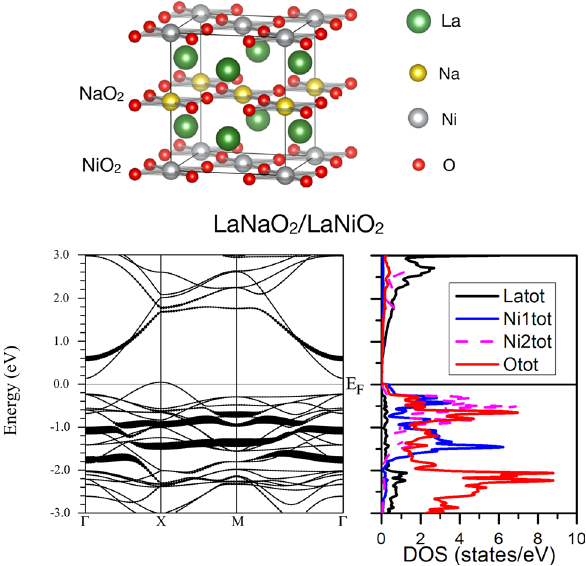
Figure 5. Top panel. Supercell constructed alternating one layer of LaNiO 2 and one layer of LaNaO 2 . The Ni-Ni direct off-plane hopping is blocked structurally by a single layer of LaNaO 2 . However, the La- d off-plane hopping is not blocked. Na atoms in yellow, La atoms in green, O atoms in red, Ni atoms in gray. Bottom left panel. Band structure of a multilayer (LaNaO 2 ) 1 /(LaNiO 2 ) 1 obtained with a very small U = 1.5 eV. A gap opening together with AF ordering occurs when the off-plane coupling is geometrically suppressed, even when the La- d - La- d off-plane hopping is permitted. Only one spin channel is shown and the La- f states are unoccupied and away from the Fermi level. The Ni- d z 2 bands are highlighted for both Ni atoms antiferromagnetically coupled (a Hund splitting can be noticed between them as before). Bottom right panel. Corresponding La, O (only the O atoms in the NiO 2 plane are shown), and Ni atom-resolved density of